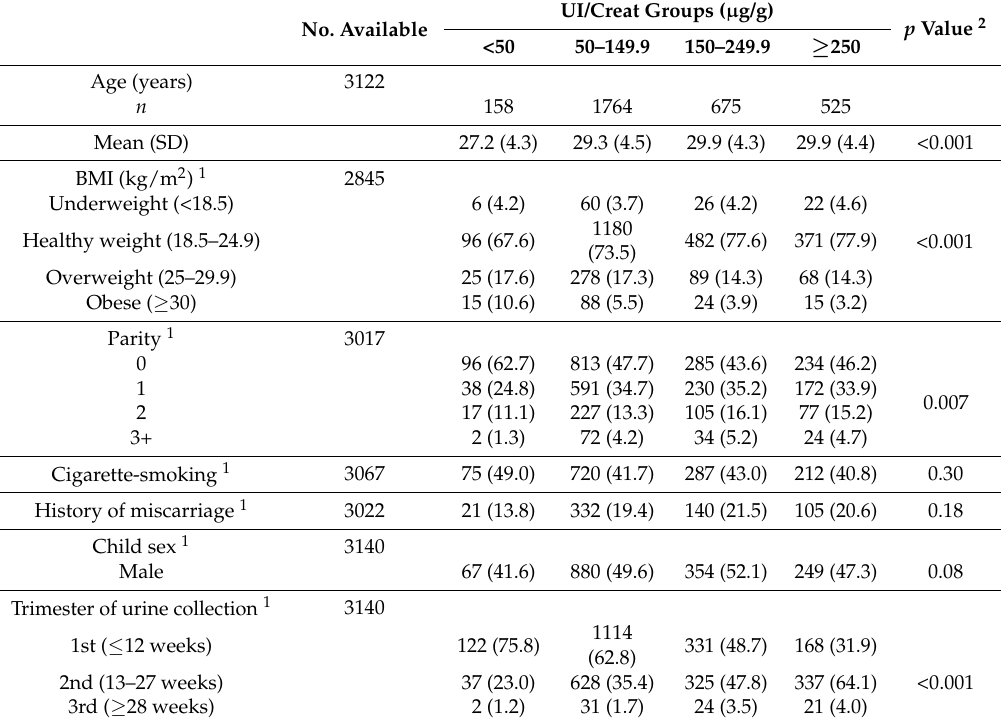
Table 2. Demographic characteristics across groups categorised by urinary iodine-to-creatinine ratio (UI/Creat) of 3140 pregnant women with babies alive at one